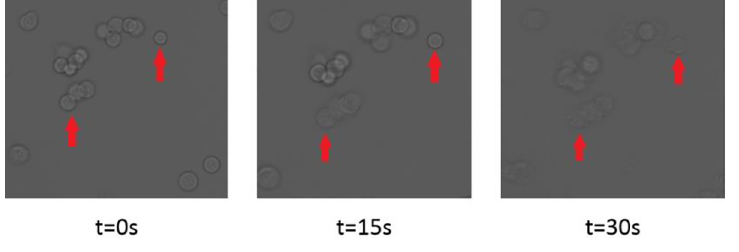
Fig 5. Micrograph of the thermo-electric lysis of MCF7 cells inside the chip. A 230 V pp sine wave at a frequency of 20 kHz was applied to the coplanar chip electrodes for 30 sec. Disintegration of the cell membranes became evident after 15 sec. After 30 sec., the structural integrity of the cell membranes was